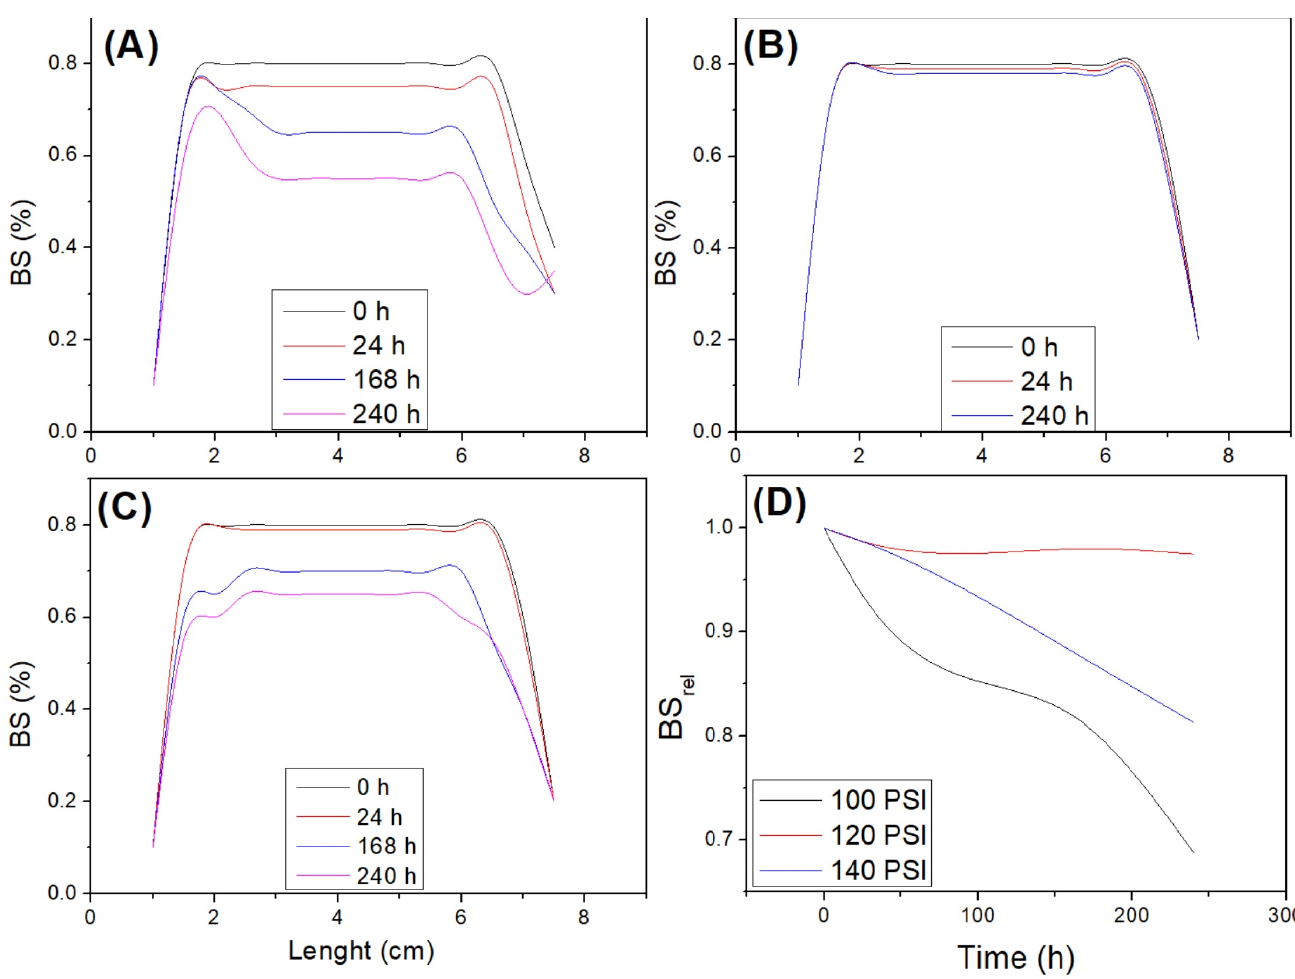
Figure 4. Backscattering (BS) measurements for the system processed at 100 PSI ( A ), 120 PSI ( B ) and 140 PSI ( C ). Relative backscattering (BS rel ) for the three systems obtained was also included ( D ).